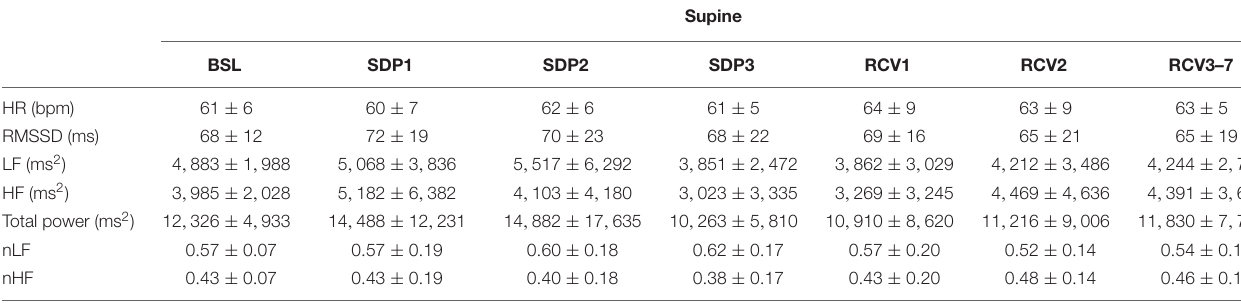
TABLE 1 | Heart rate variability (HRV) parameters in supine position.